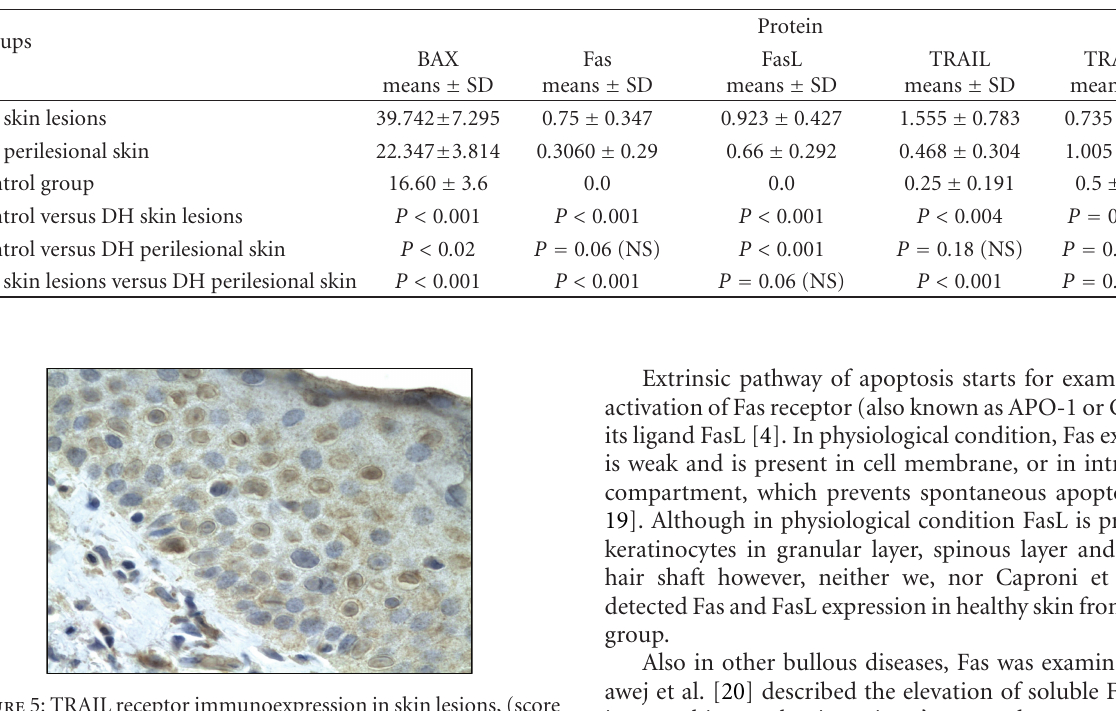
Table 1: Expression of proteins in examined tissues. Statistical results. Data expressed as means ± SD; ∗ P < 0 . 05.